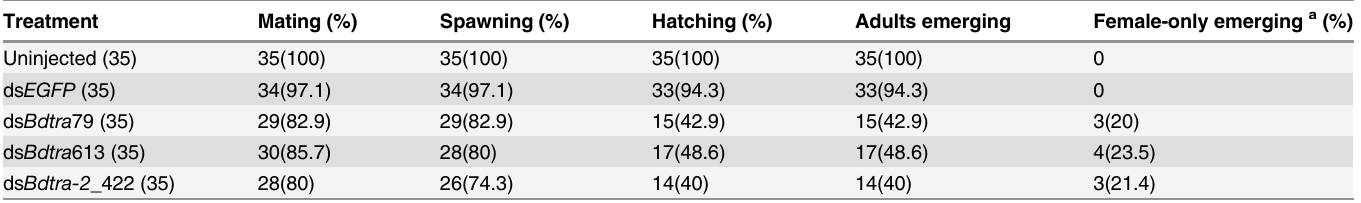
Table 2. Backcrosses of XX and XY males from dsRNA injected eggs were backcrossed to wild females in 35 cages. Treatment